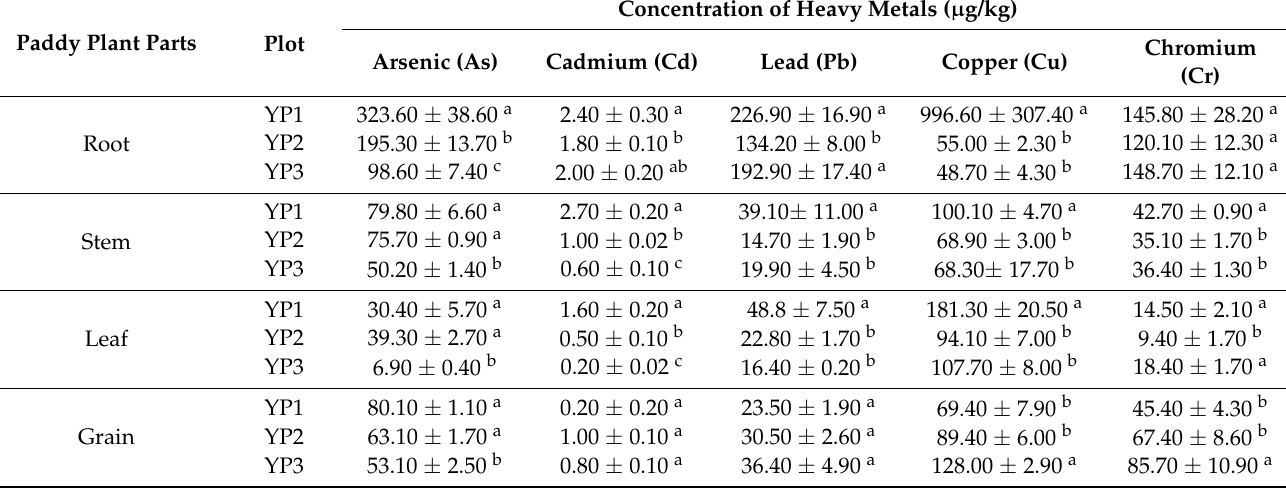
Table 2. Concentration of heavy metals in paddy plant parts from the Yan